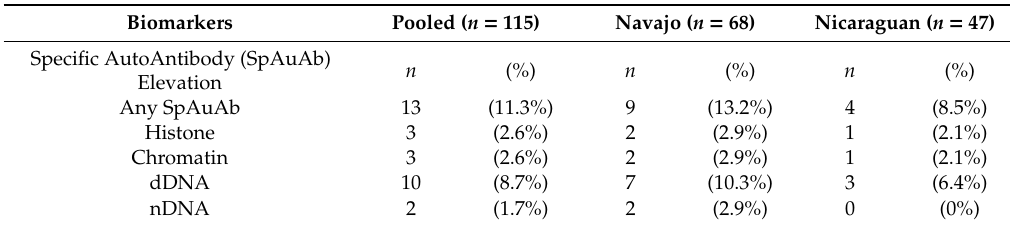
Table 3. Multivariable logistic regression results: Odds of association between urinary metals concentrations (µg/g creatinine) by tertile with first tertile as reference (REF) and any ANA positivity ( ≥ 2+) at cellular sites.